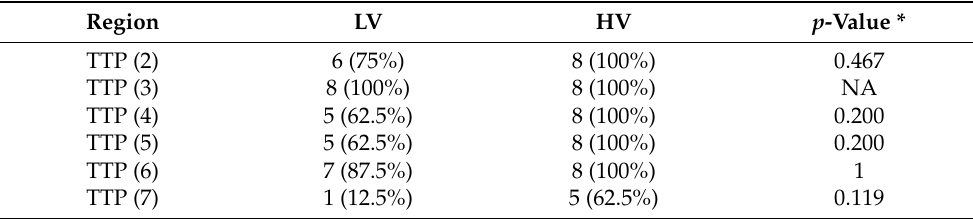
Table 2. The table shows the number and percentage of transversus thoracis plane intercostal seg- ments between T2–T7 stained after performing the two-point technique for the transverse approach to the transversus thoracis plane with both volumes.